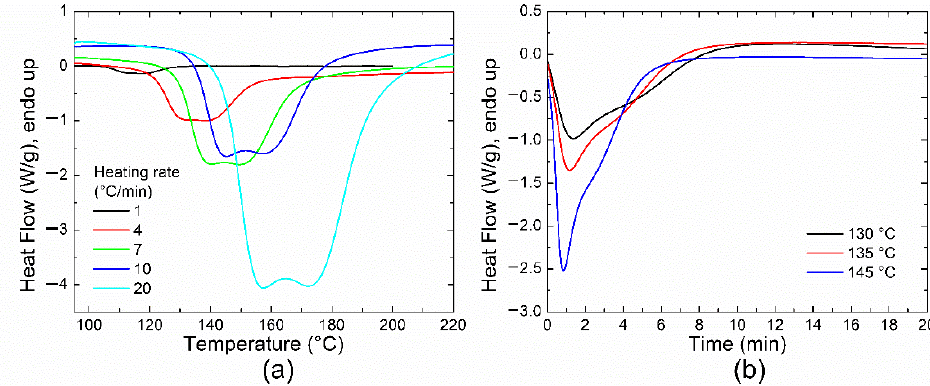
Figure 2. ( a ) DSC curves at different heating rates; ( b ) isothermal thermograms for the Aerotuf resin.